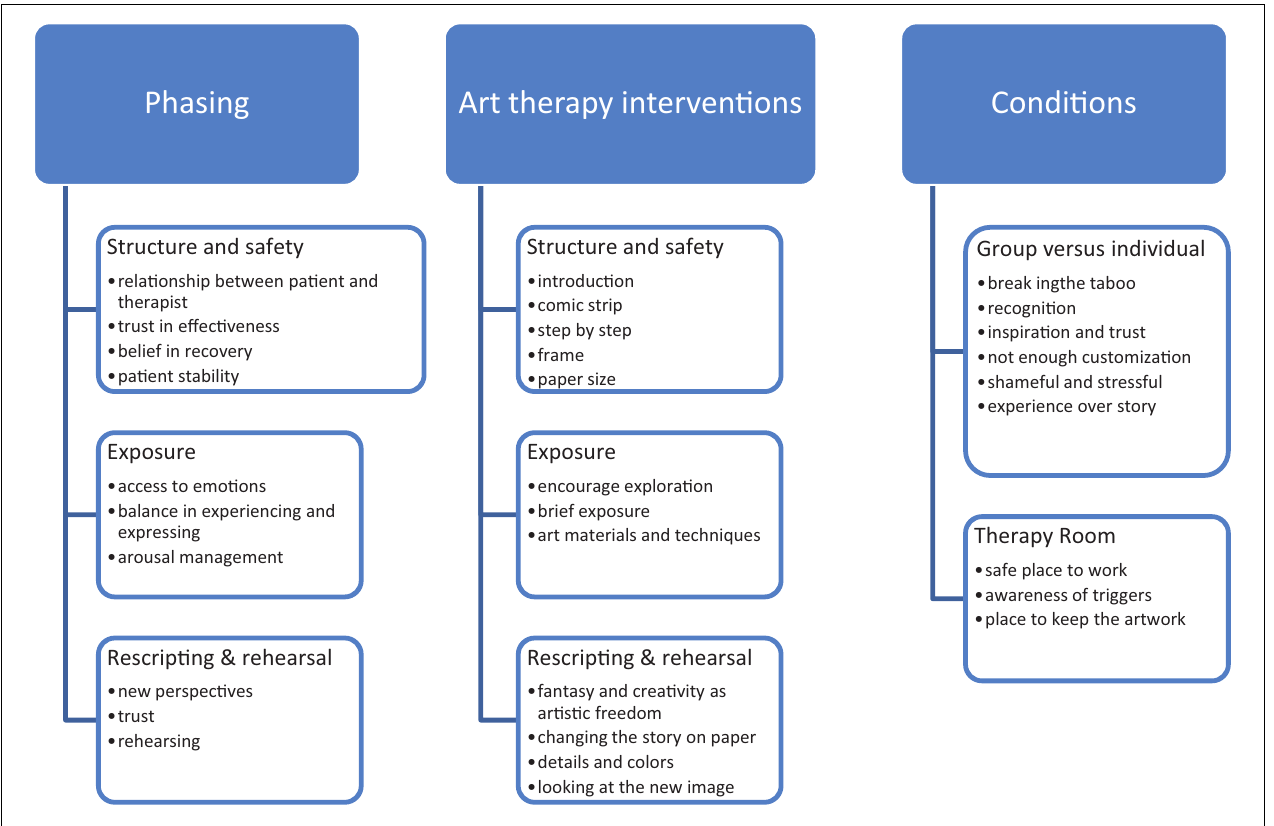
FIGURE 4 | Major themes and content for imagery rehearsal-based art